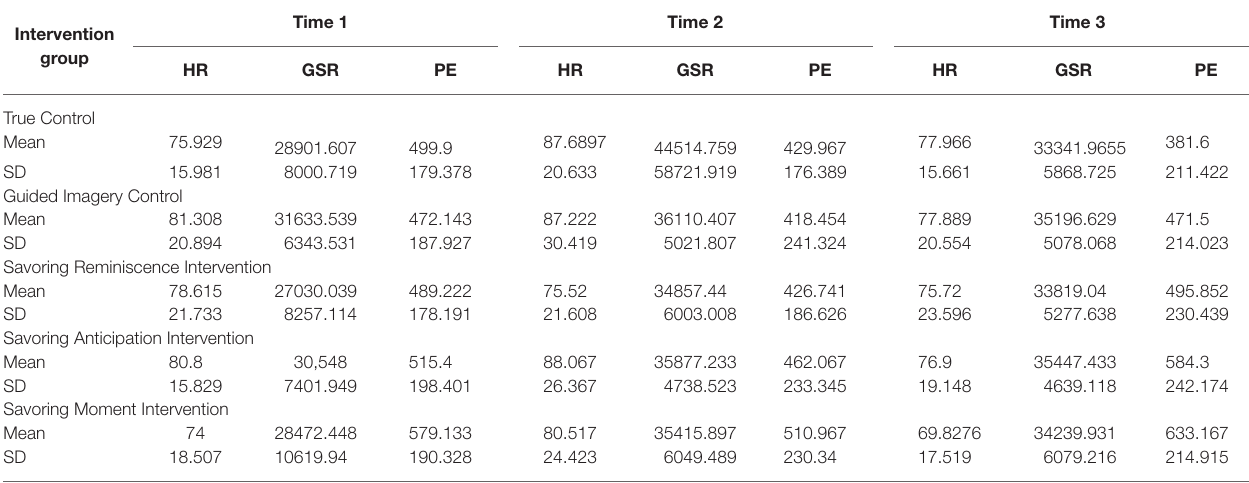
TABLE 1 | Means and standard deviation scores for heart rate (HR), galvanic skin response (GSR), and positive emotions (PE) across time points and intervention groups. Intervention group